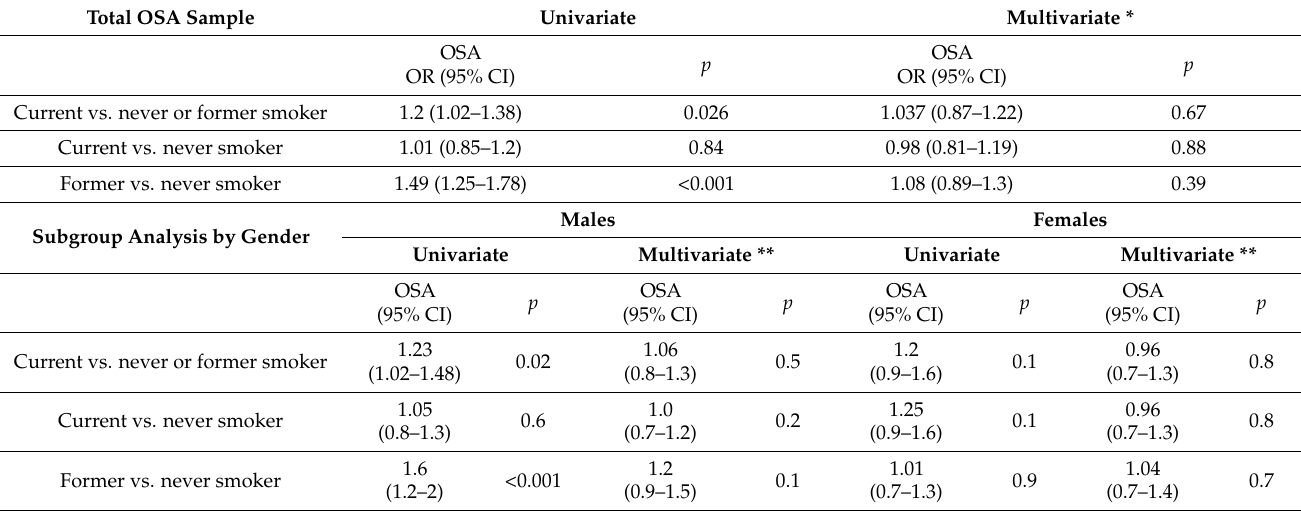
Table 6. Risk of Obstructive Sleep Apnea (OSA) associated with current smoking and former smoking estimated by unadjusted and adjusted Odds Ratio (OR) and 95% Confidence Intervals